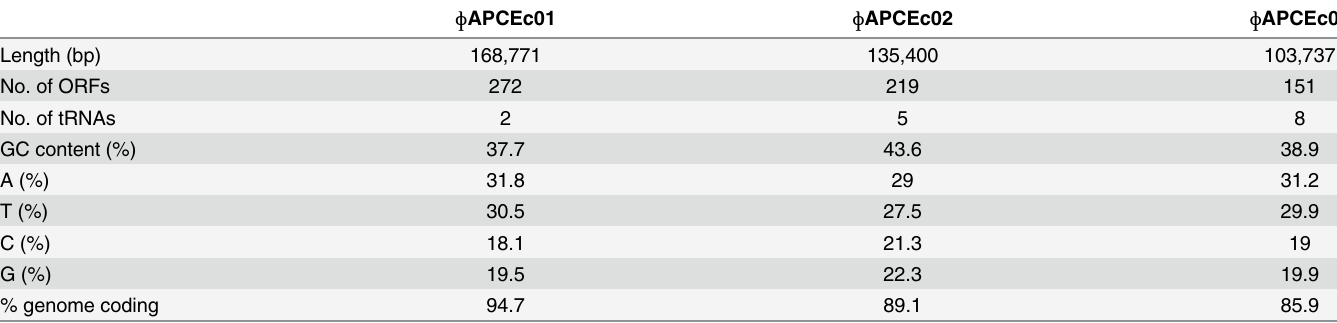
Table 3. Genome features of phages ɸ APCEc01, ɸ APCEc02 and ɸ APCEc03.